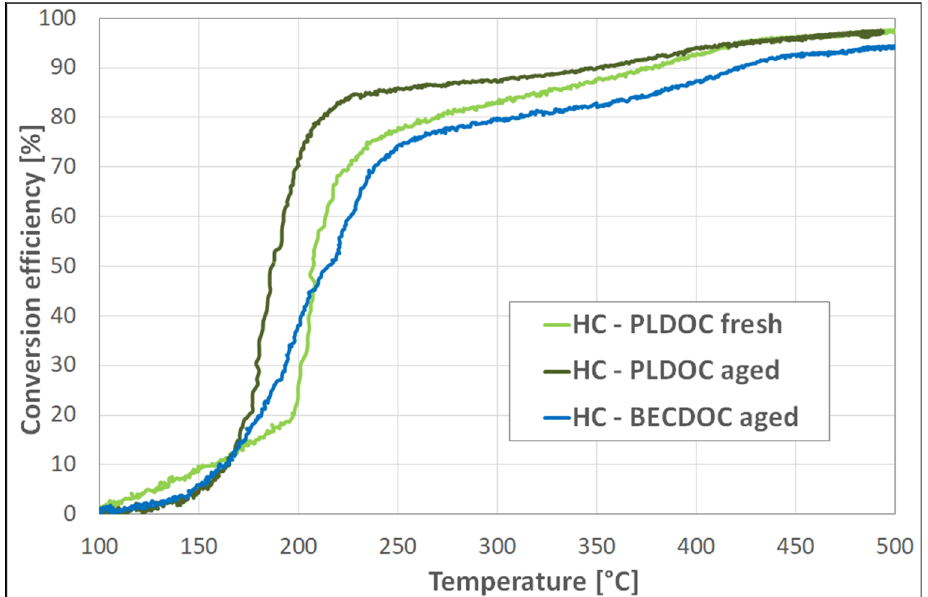
Figure 10. DOC light-off test: HC conversion efficiencies.